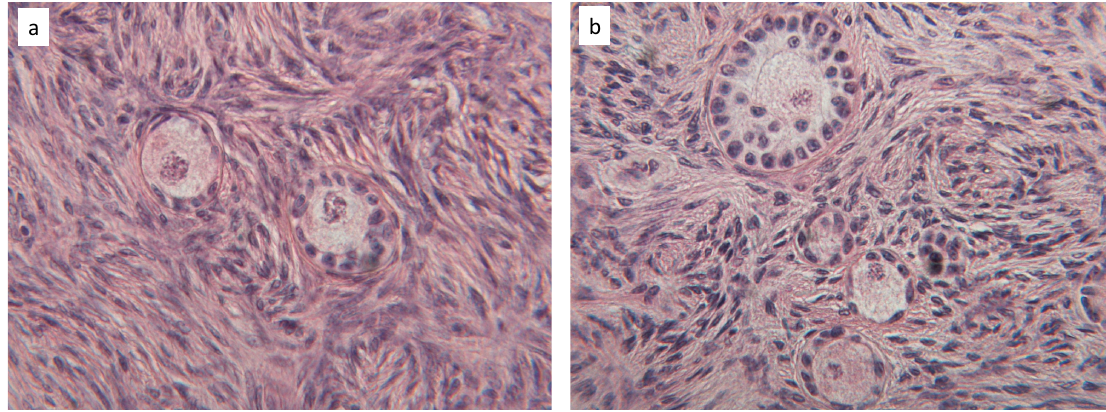
Figure 9. Exemplary histological sections of cortical ovarian tissue before ( a ) and after ( b ) mechanical testing.